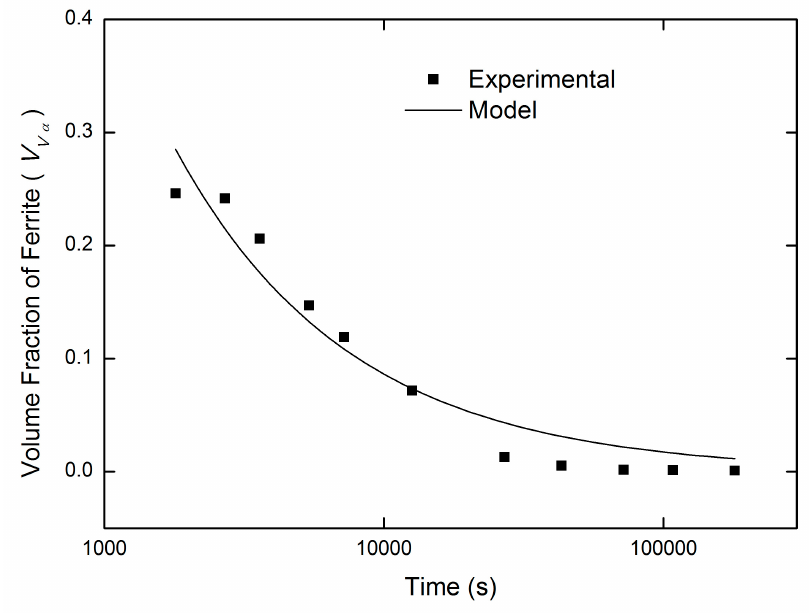
Figure 6. The volume fraction of ferrite as a function of the aging time, at 750 °C.